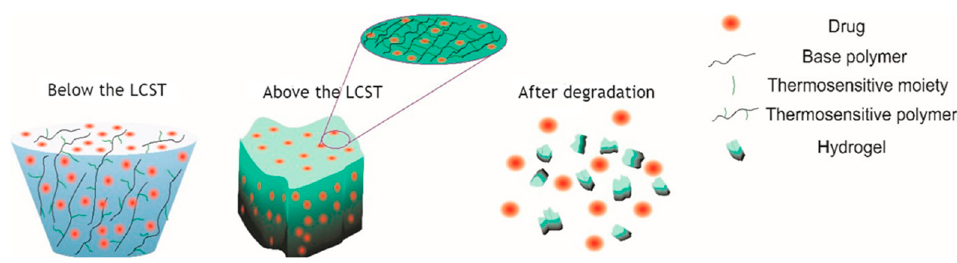
Figure 4. Diagram showing the degradation of the thermosensitive hydrogel below and above the LCST [65].